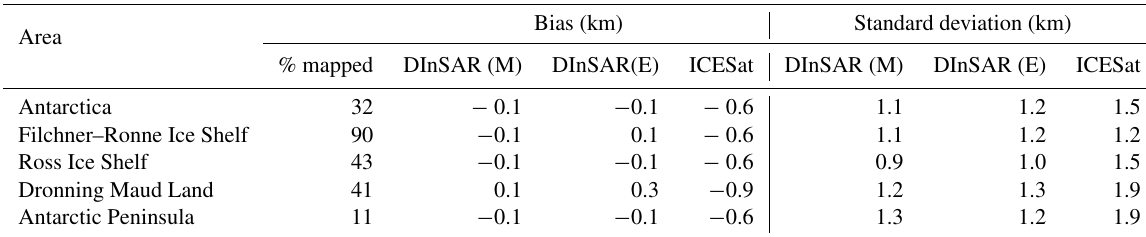
Table 1. The percentage of grounding line mapped along with the bias (a negative value represents a landward bias) and standard deviation between the CryoSat-2-mapped grounding line (point F) and the DInSAR- ((M)EaSUREs and (E)SA CCI) and ICESat-mapped grounding lines, for several regions across Antarctica (shown in Fig.